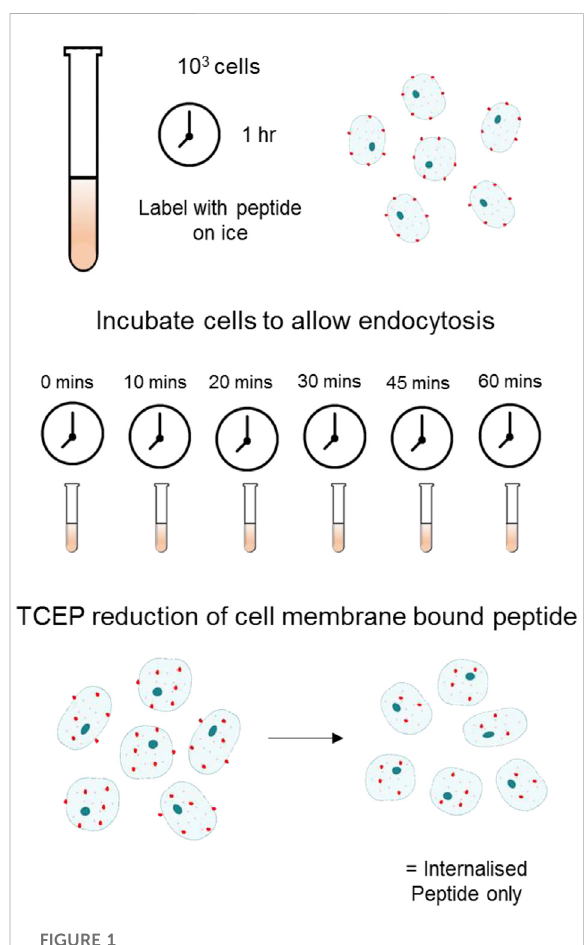
FIGURE 1 Schematic of Flow Cytometry Internalisation Assay using TCEP Reduction Cells labelled with a fl uorescently tagged peptide were incubated at 37 ° C in appropriate cell culture medium + FBS for the indicated time allowing for internalisation. Following endocytosis and washing, 100 mM of TCEP was added to each sample to cleave the fl uorochrome selectively from the surface bound pool of